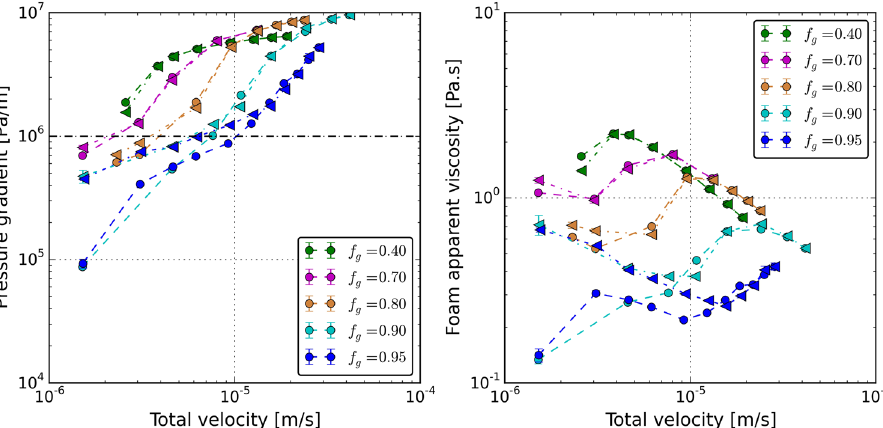
Figure 4. ( a ) The pressure gradient along the core and ( b ) the calculated apparent viscosity at different total velocities. The horizontal dashed line in 4a indicates the critical pressure gradient below which the hysteresis in foam generation